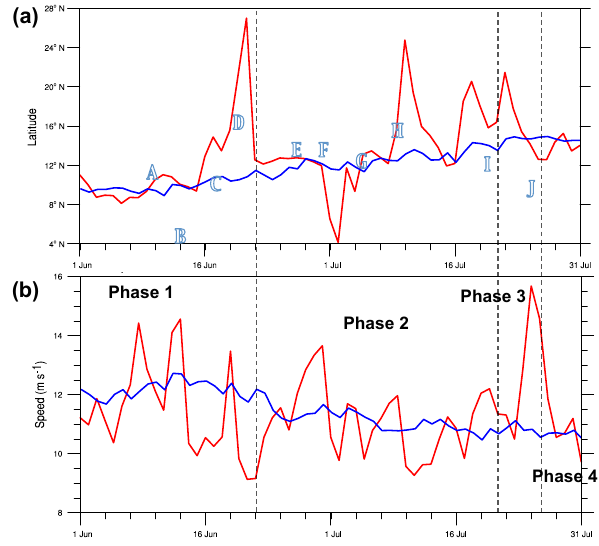
Figure 8. AEJ evolution during June–July 2016. Time series of (a) latitudinal position and (b) mean speed in metres per second of the AEJ objectively identified from ERA-I reanalysis data. The red lines indicate the 2016 evolution, the blue lines the 1987–2016 climato- logical mean (see Sect. 2.2 for more details). The four phases of the DACCIWA campaign are indicated by vertical lines. The significant synoptic-scale features A–J are marked at the approximate time and latitude of crossing the DACCIWA focus